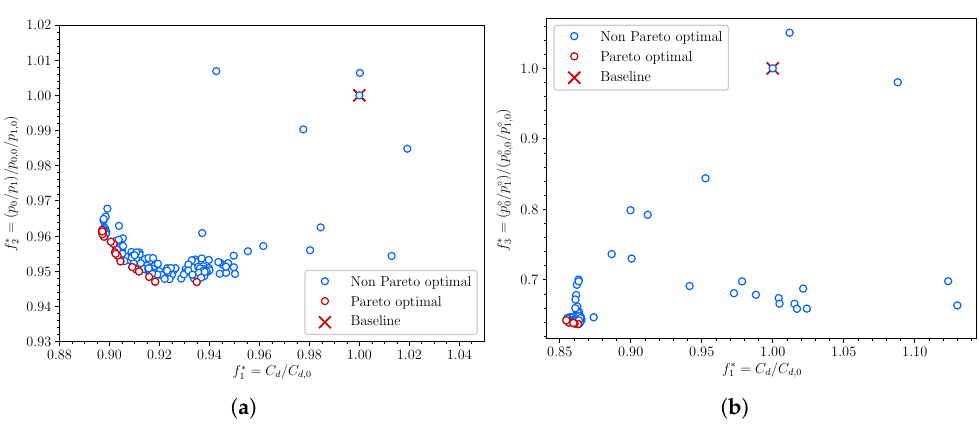
Figure 9. Baseline-scaled Pareto fronts concerning the two objective optimizations. ( a ) Non- dimensional f 1 / f 2 Pareto front; ( b ) Non-dimensional f 1 / f 3 Pareto front.